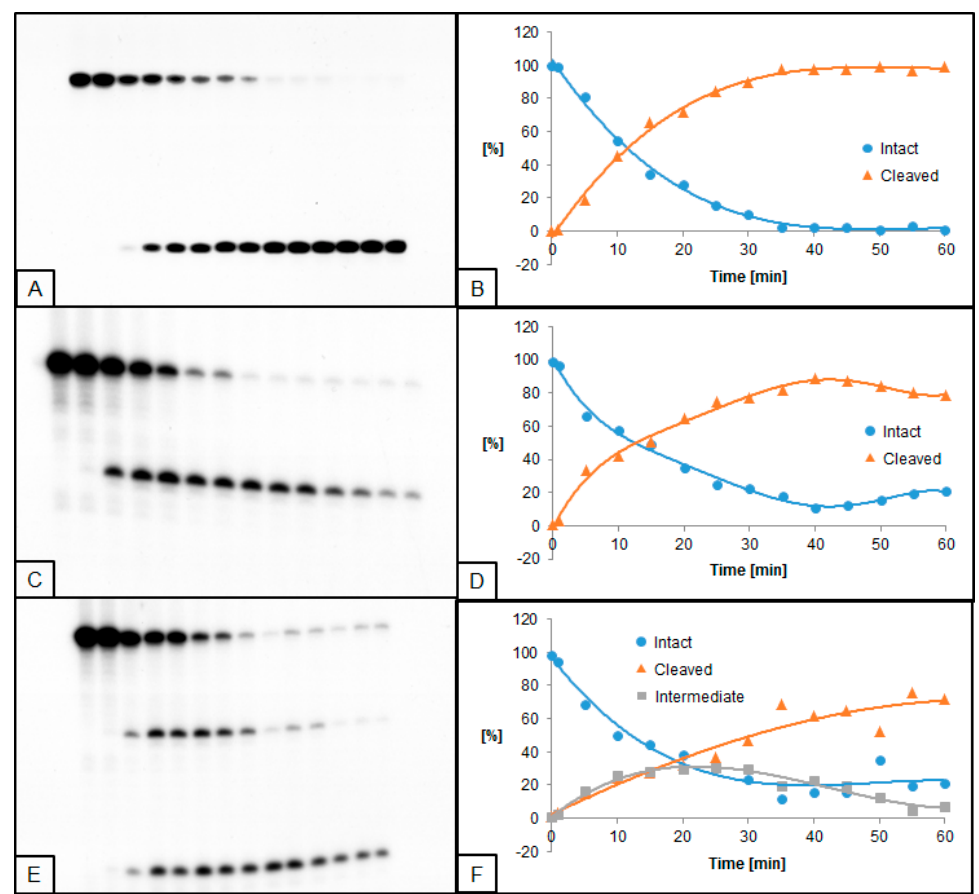
Figure 3. Cleavage of dsDNA containing dU and (5 ′ R ) − 5 ′ ,8-cyclo-2 ′ -deoxyadenosine (RcdA) by 0.02 U UDG and 0.5 U hAPE1. ( A , B ) dU( − 5)RcdA; ( C , D ) dU(+5)RcdA; ( E , F ) dU( − 5)(+5)RcdA. ( A , C , E ) show 14 lanes each, which correspond to reaction times 0, 1, 5, 10, 15, 20, 25, 30, 35, 40, 45, 50, 55, and 60 min starting from the left. ( B , D , F ) show the quantity losses of intact ssDNA (blue), the quantity increases of SSB-DNA (orange), and an intermediate oligo fragment (grey).